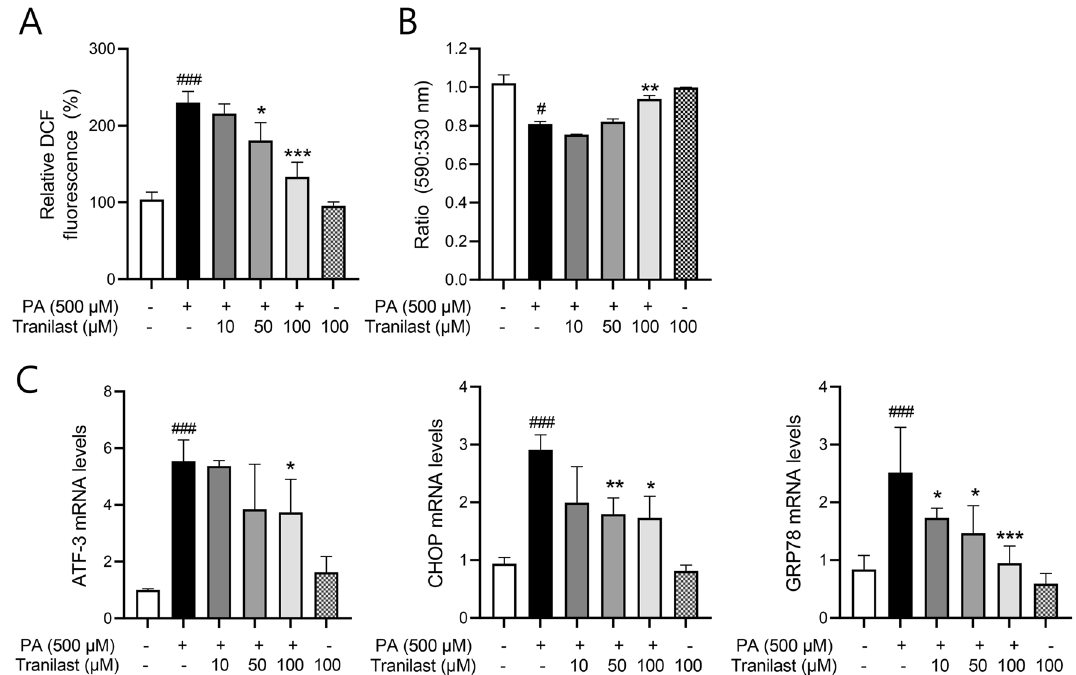
Figure 3. Tranilast reduces PA-induced oxidative and ER stress in INS-1 cells. ( A ) INS-1 cells were treated with PA (500 μM) in the presence or absence of tranilast at the indicated concentrations. Intracellular ROS levels in the treated-cell lysates were detected by DCF fluorescence using a colorimetric assay kit as described in Methods. ( B ) Treated cells were stained with JC-1 probe and analyzed using a fluorescence spectrophotometer. ( C ) mRNA expression of ER stress markers was determined by real-time qPCR. Data are expressed as mean ± SD of three independent experiments, each done in duplicate. # p < 0.05, ### p < 0.005 versus